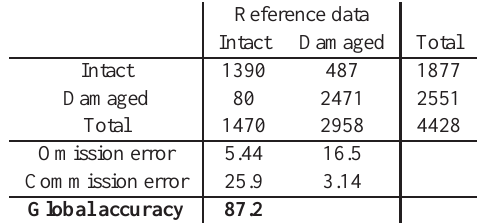
Table 4: Confusion matrix for binary classification (In- tact/Damaged)